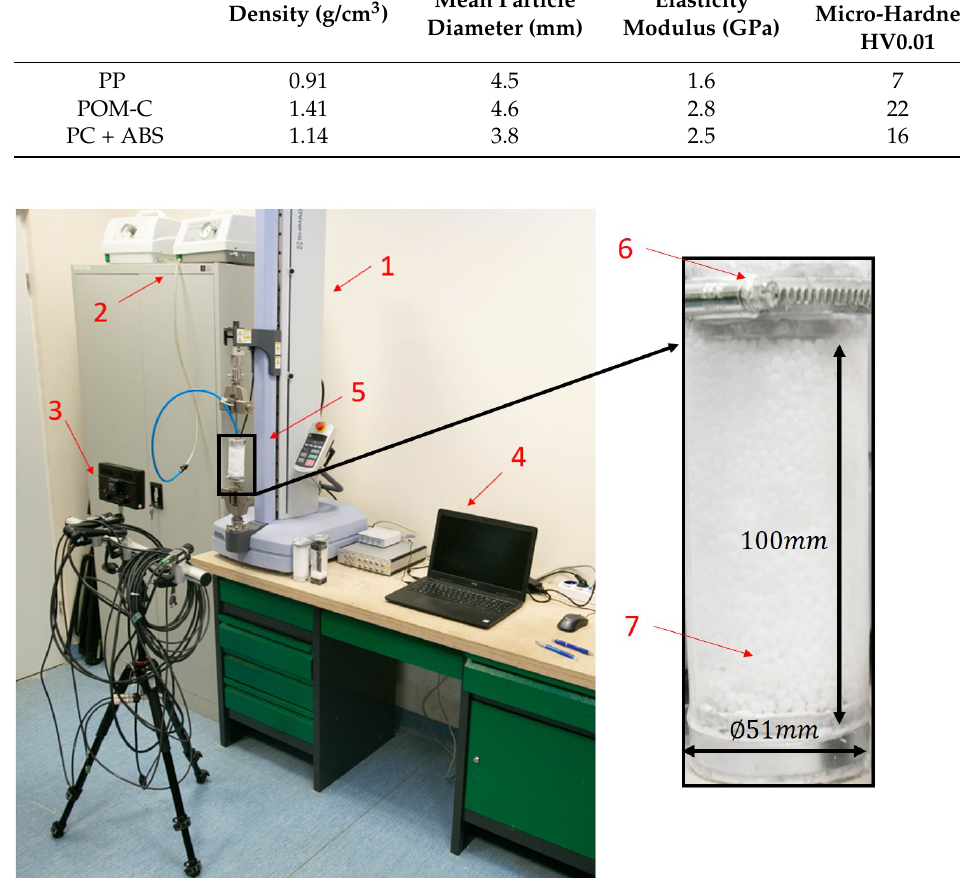
Figure 1. Test stand. 1—the testing machine, a SHIMADZU EZ-LX, 2—vacuum pump, 3—DANTEC DIC system, 4—main computer, 5—testing sample, 6—sample rigid disk, 7—granular